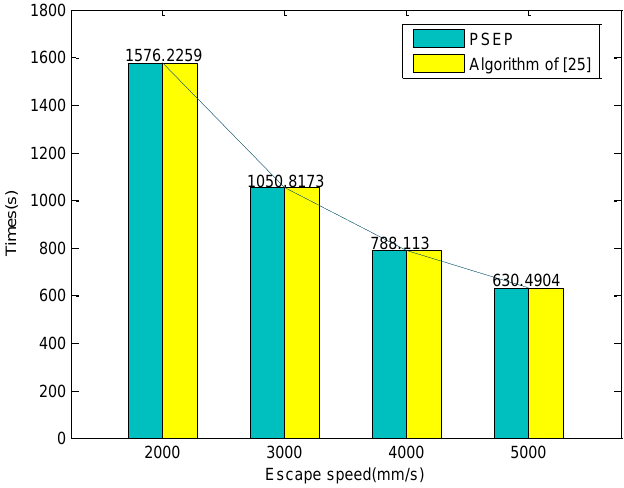
Figure 9. Comparison of their total evacuation time varying with the escape speed.